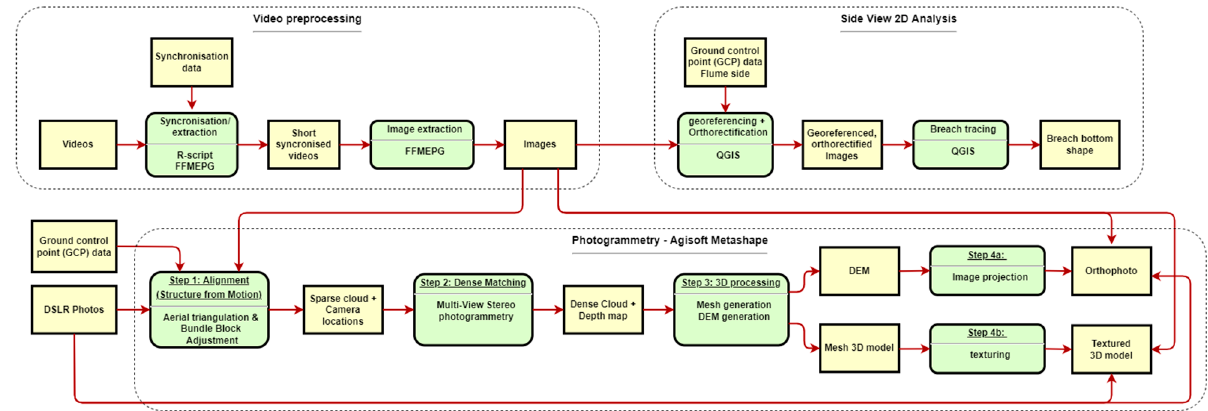
Figure 7. Photogrammetry and image analysis work fl ow.